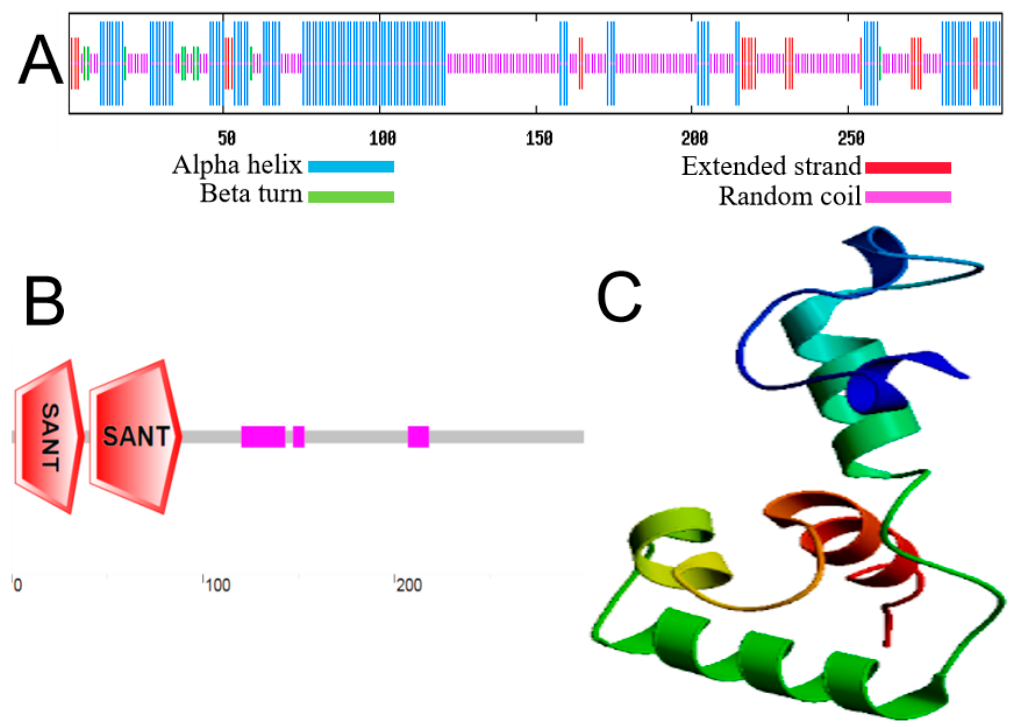
Figure 2. Structural prediction of MbMYB108 protein. Prediction of the secondary structure ( A ), domains ( B ), and tertiary structure ( C ).